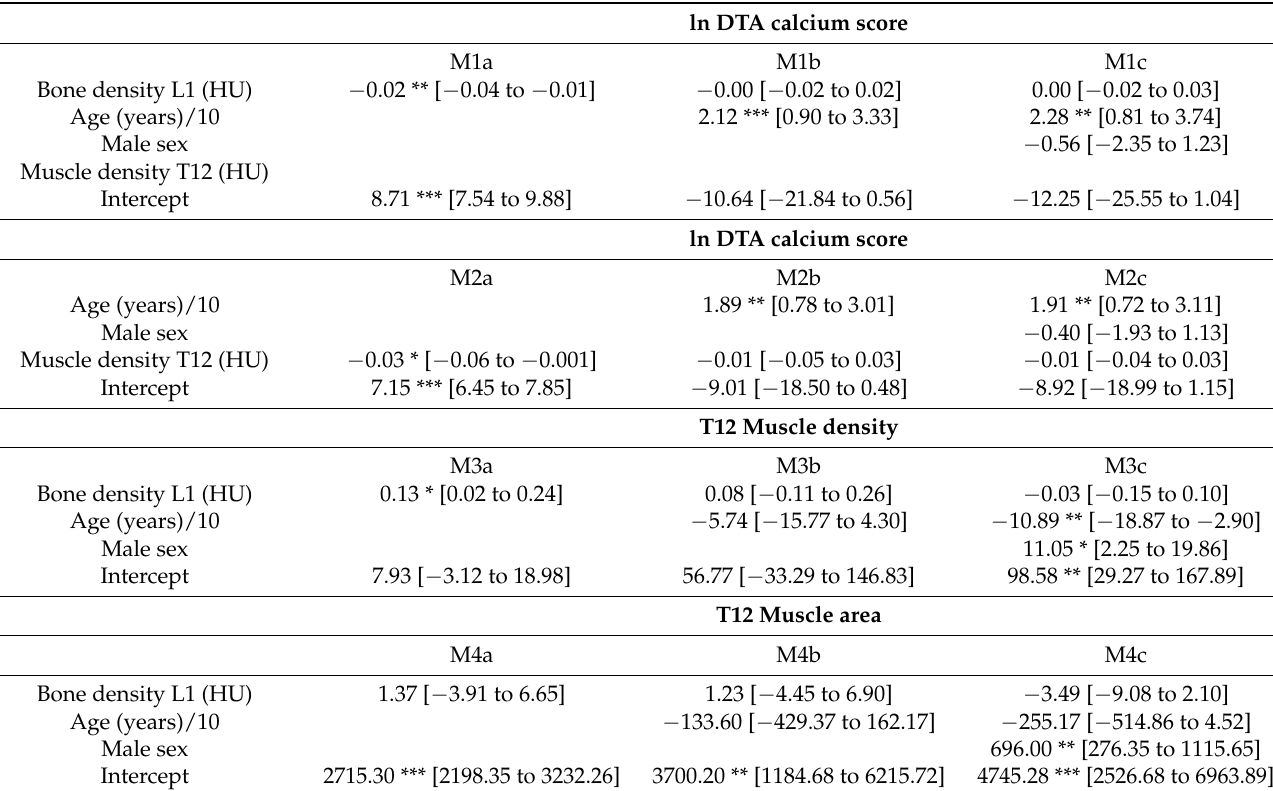
Table 2. Univariable and multivariable median regression models used to evaluate the association between ln DTA calcium score and bone density, ln DTA calcium score and muscle density, muscle density and bone density and muscle area and bone